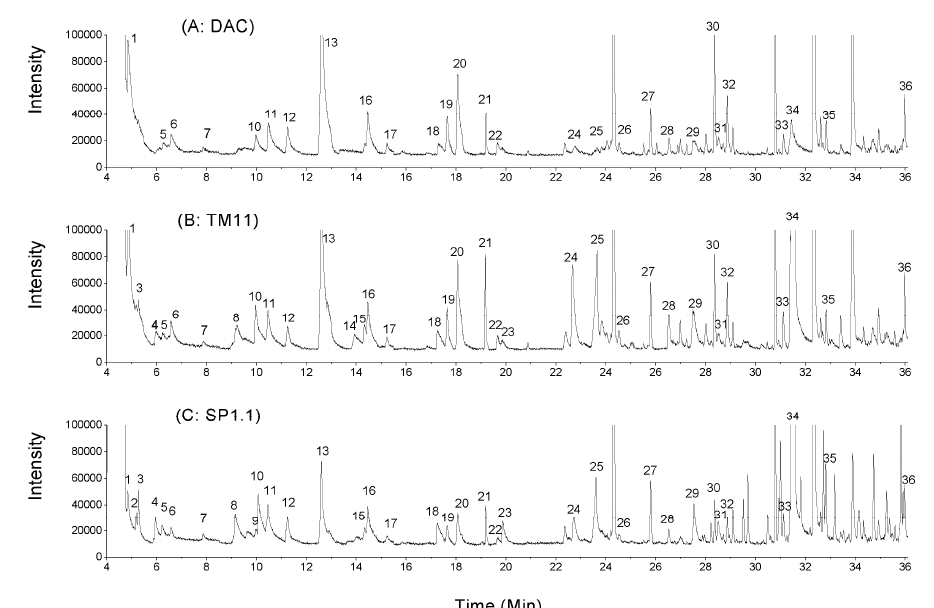
Figure 1. Comparison of typical total ion currency (TIC) profile of the volatiles from the direct-acidified cheese ( A : DAC) and the cultured cheeses with S. thermophilus ( B : TM11 and C : SP1.1). Peak numbers, 1–36, were marked. Alkanes, heterocyclic compounds excluding indene, pollutants (such as naphthalene, 32.34 min) and the un-identified chemicals were not